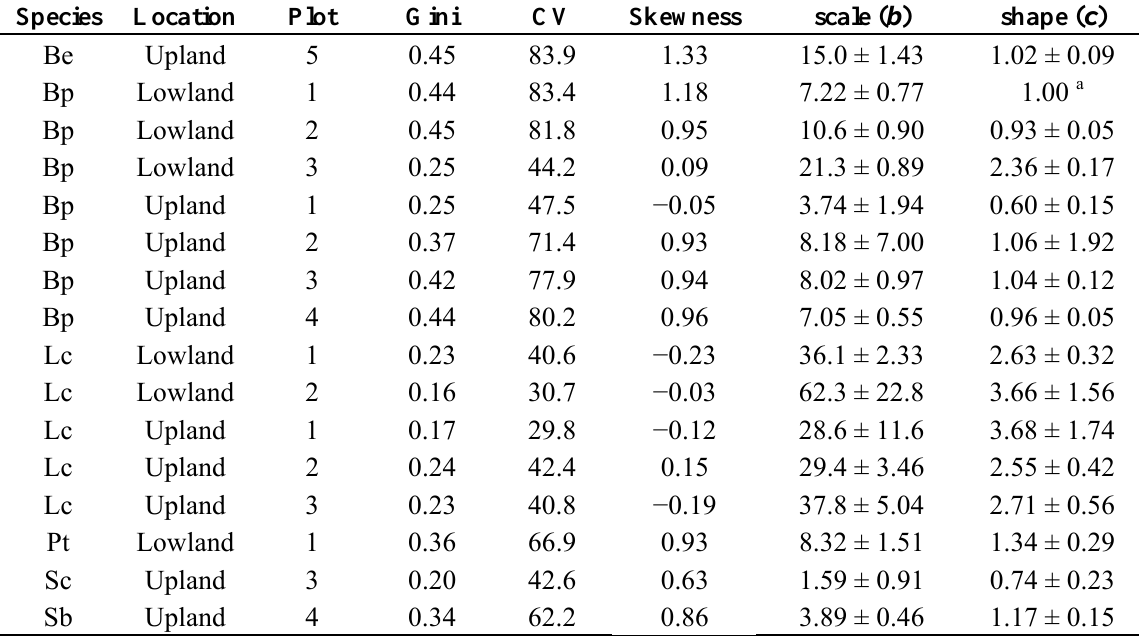
Table 7. Stem size inequality and distribution within old-growth forest plots in Central Kamchatka: Gini co-efficient (Gini), co-efficient of variation (CV), skewness and scale ( b ) and shape ( c ) parameters (means ± SE) of a three-parameter Weibull distribution fit by maximum likelihood. Be = Betula ermanii , Bp = B. platyphylla , Lc = Larix cajanderi , Pt = Populus tremula , Sc = Salix caprea , Sb = S. bebbiana